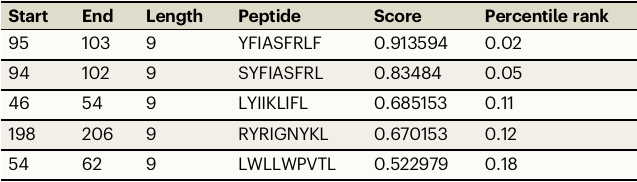
Table 1 | The candidates of SARS-CoV-2-M epitopes for HLA-A*24:02